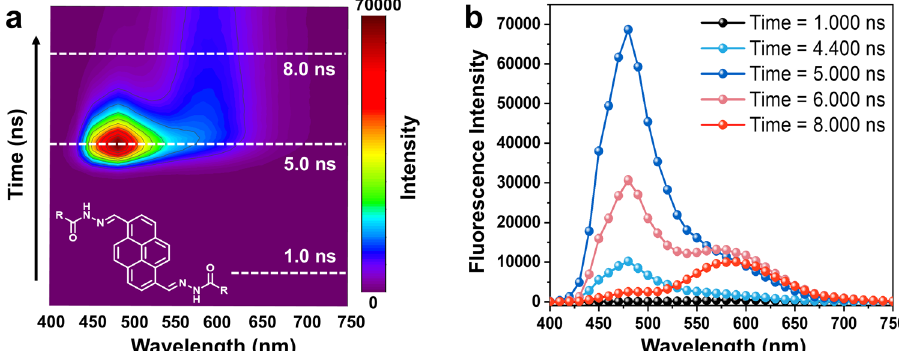
Fig. 3 Excimer formation process. Time-resolved fl uorescence ( a ) mapping and ( b ) spectroscopy of compound PY16 in aqueous solution (25 °C, 20 μ M). The solution of PY16 contained 10% (volume ratio) dimethyl sulfoxide to enhance monomeric emission. The redshift of the emission over time indicated the formation of